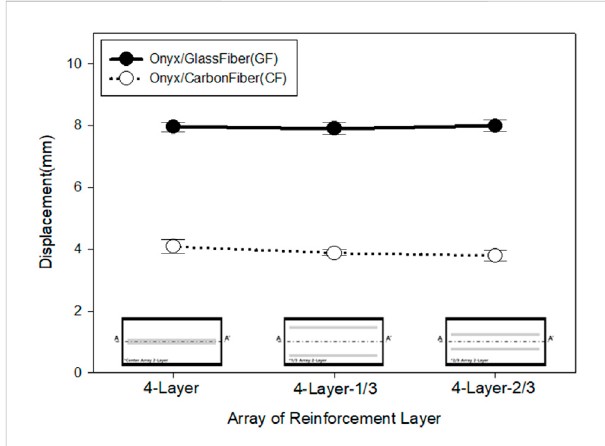
FIGURE 8 Stress-Strain curve depending on the position of 2-layer reinforcement.